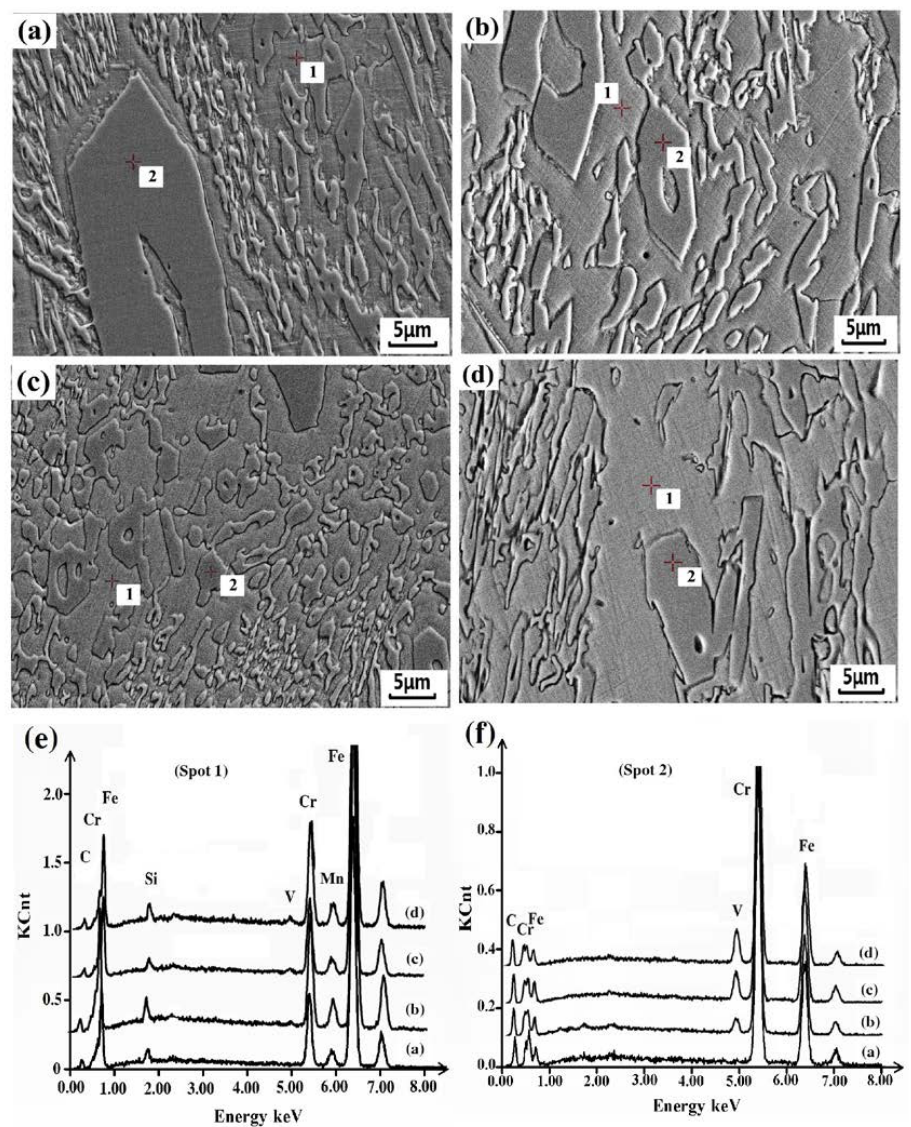
Figure 9. EDS analysis of different phases in HCCI hardfacing layers with different V contents, 1-EDS test point of matrix, 2-EDS test point of M 7 C 3 ( a ) 0 V, ( b ) 0.83 V, ( c ) 1.50 V, ( d ) 2.32 V, ( e ) EDS of matrix, ( f ) EDS of M 7 C 3 .